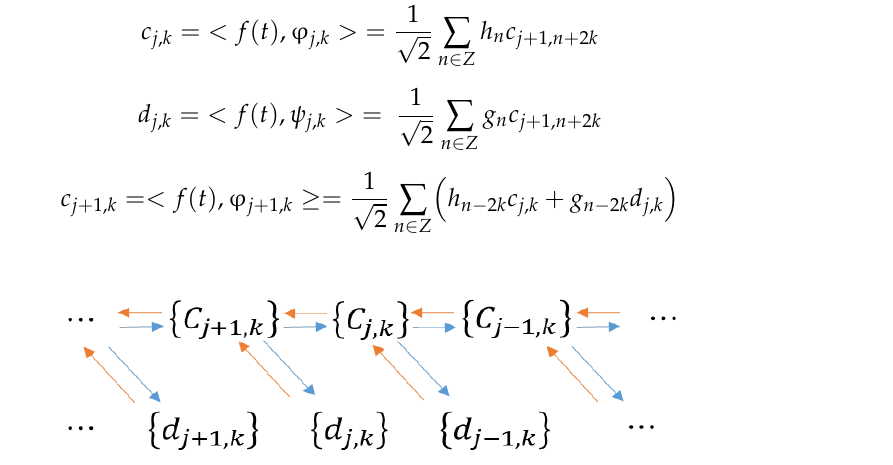
Figure 2. Mallat decomposition and reconstruction algorithm. Directions of blue and red arrows indicate the decomposition and reconstruction algorithms, respectively.